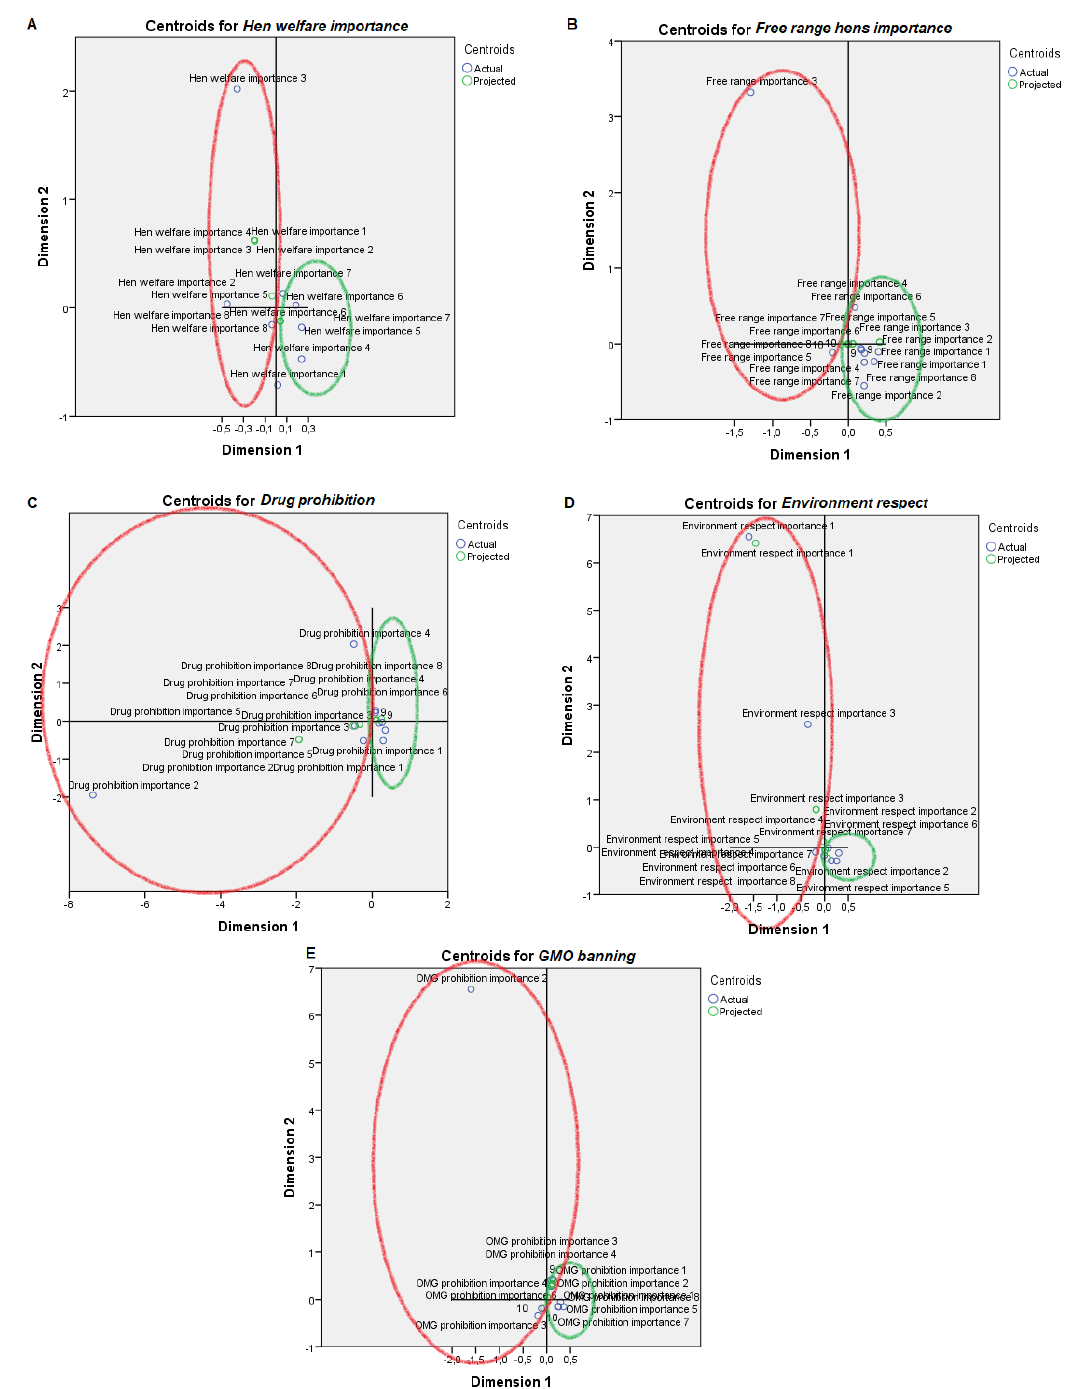
Figure 3. Object scores plot visualization of Professional Customer Profiles with regards production context awareness, egg consumption non-affine profile or PPA (red), and affine profile or PPB (green). Production context awareness was scored through: ( A ) Hen welfare importance, ( B ) Free range hens importance, ( C ) Drug prohibition, ( D ) Environment respect and ( E ) GMO banning.